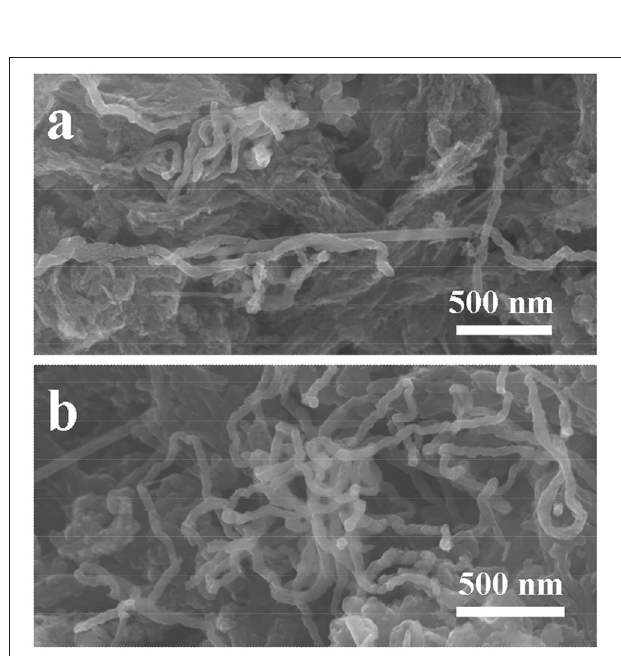
FIGURE 6 | FE-SEM images of the S2 electrode after cycling: (a) 250 cycles at 0.1A g − 1 ; (b) 500 cycles at 0.3A g − 1 .